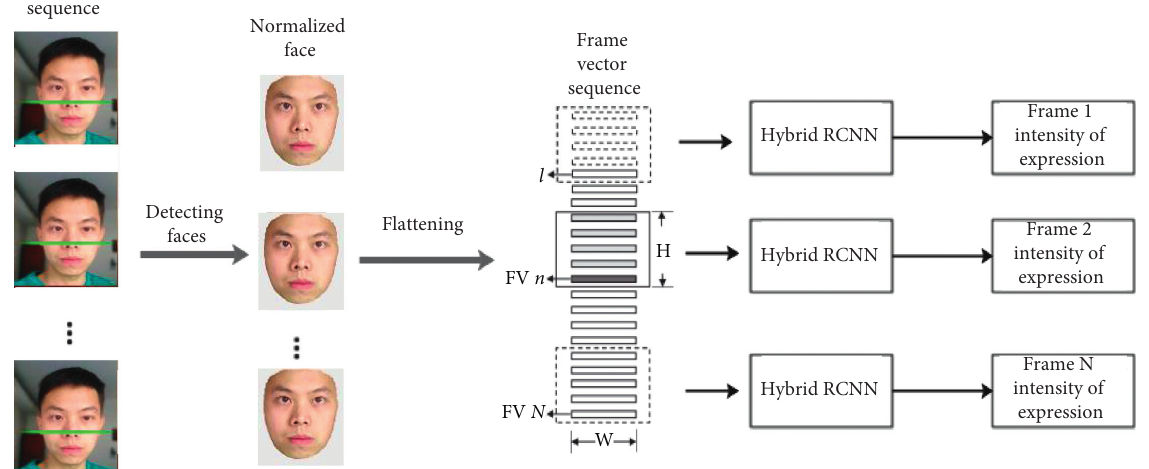
Figure 4: Frame diagram of the expression intensity evaluation